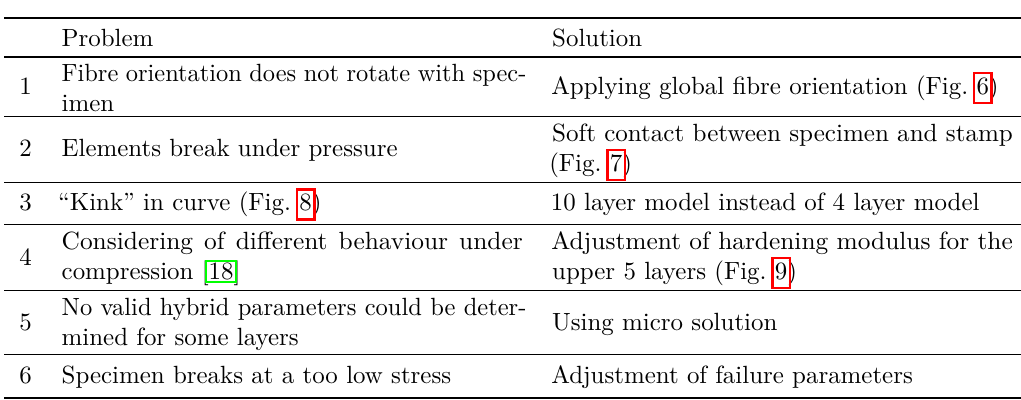
Table 3. Description of the problem and the corresponding solution for the bending simulation model.